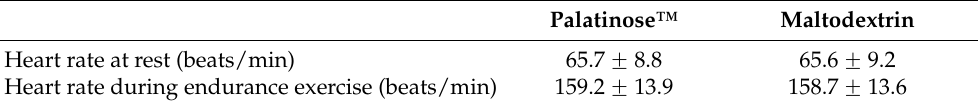
Table 1. Average heart rate at rest and during endurance exercise for the PSE and MDX trials, presented as mean ± SD ( N = 20).